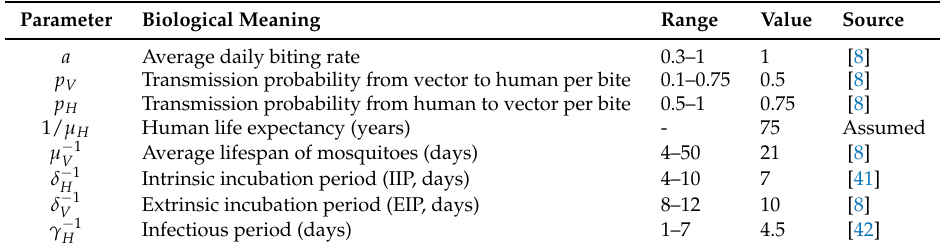
Figure 4. Flow diagram of the SEIR-SEI model of human-vector interactions. Table 1. Parameter notation, biological meaning, values and